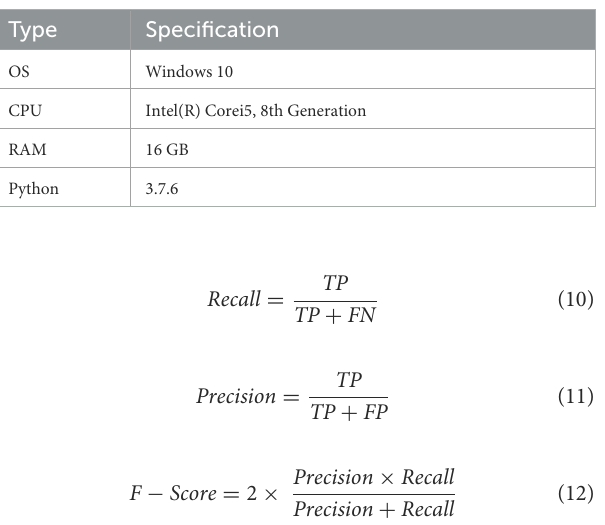
TABLE 2 Capability of the experimental